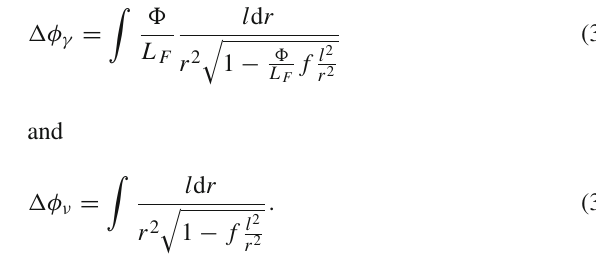
Table 1 The apparent angular diameter of two astrophysical black- holes, designated Sgr A* and M87, is given for three models of space- time, Schwarzschild, and R–N and eff-Bardeen with charge parameter q = 0 . 1 BH spacetime θ BH − SgrA ∗ ( µ arcsec ) θ BH − M 87 ( µ arcsec )